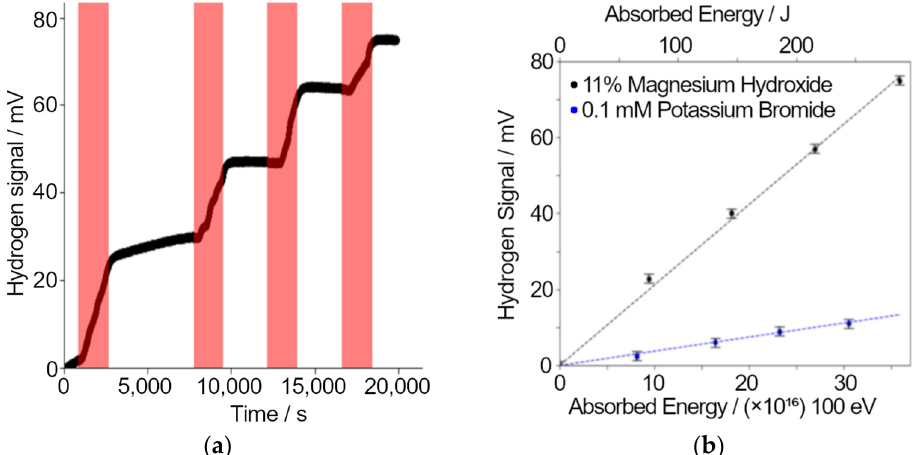
Figure 5. Results of radiolytic gas analysis experiments carried out on the particle accelerator using Unisense hydrogen probes to collect data. ( a ) The response of the hydrogen probe in mV during irradiations. Periods of irradiation are marked on the plot in red. ( b ) A linear trend is seen from experiments with fresh solutions of either magnesium hydroxide or potassium bromide.